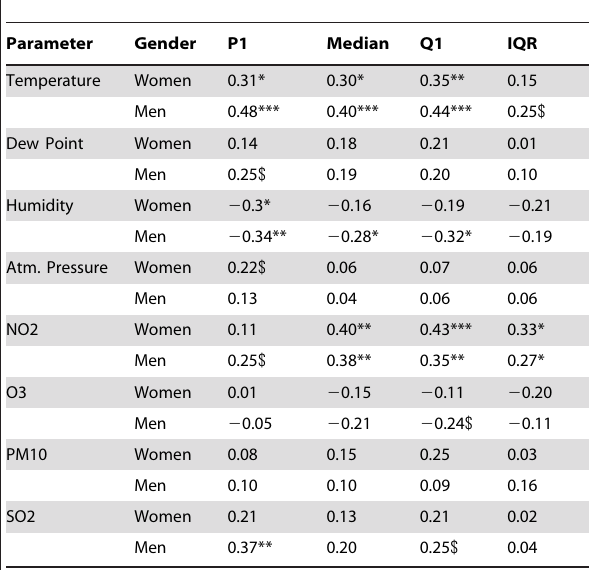
Table 2. Spearman correlations results between all marathons performance levels and environmental